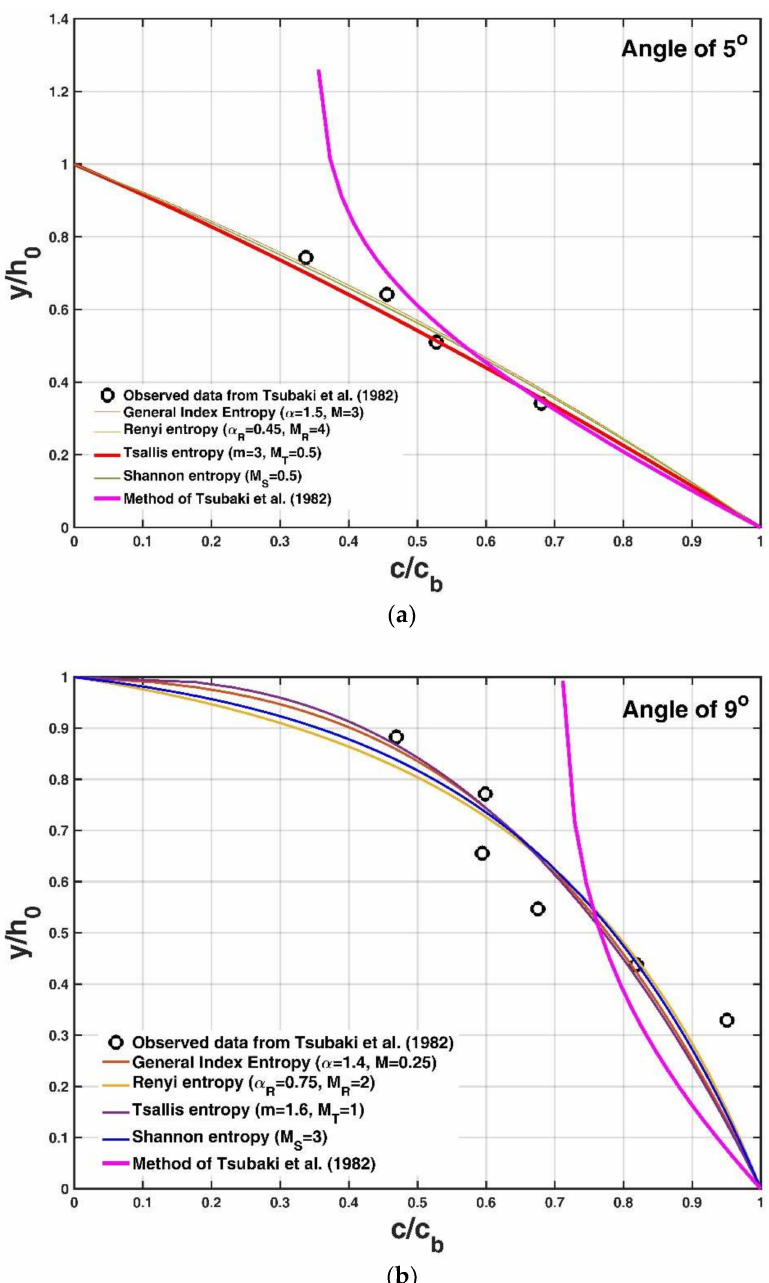
Figure 2. Comparison of the method of Tsubaki et al. [18] (Equation (1)), the general index entropy-based expression (Equation (22)), the Renyi entropy-based expression (Equation (35)), the Tsallis entropy-based expression (Equation (41)), and the Shannon entropy-based expression (Equation (47)) with observed data from Tsubaki et al. [18] at angles of ( a ) 5 ◦ and ( b ) 9 ◦